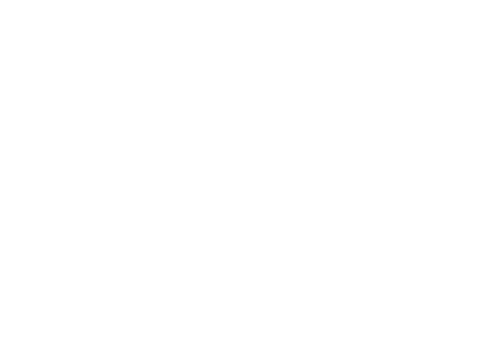
Table 6. TR values of As, Pb, Cd and Cr for different species.